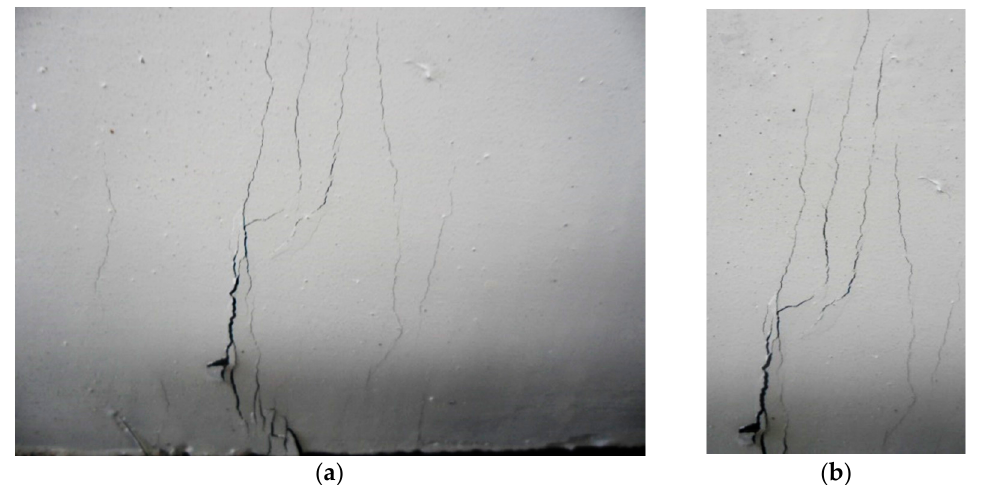
Figure 7. Typical cracking at the bottom of the UHPC segments. ( a ) Cracking at intrados face of segment, ( b ) Closer view of cracks.